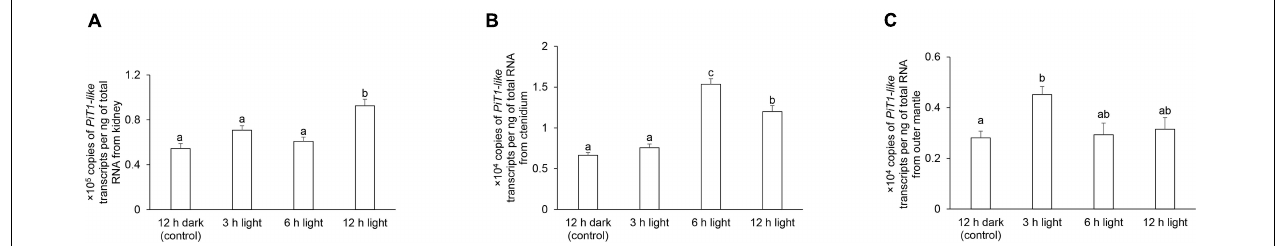
FIGURE 7 | Transcript levels of a homolog of sodium-dependent phosphate transporter protein 1 ( PiT1-like ) from the (A) kidney, (B) ctenidium, and (C) outer mantle of Tridacna squamosa kept in darkness for 12 h (control), or exposed to light for 3, 6, or 12 h. Transcript levels of PiT1-like expressed as × 10 5 copies of transcript per ng total RNA for kidney, or × 10 4 copies of transcript per ng total RNA for ctenidium and outer mantle. Results represent means + SEM ( n = 4). Means not sharing the same letter are significantly different ( p -value <